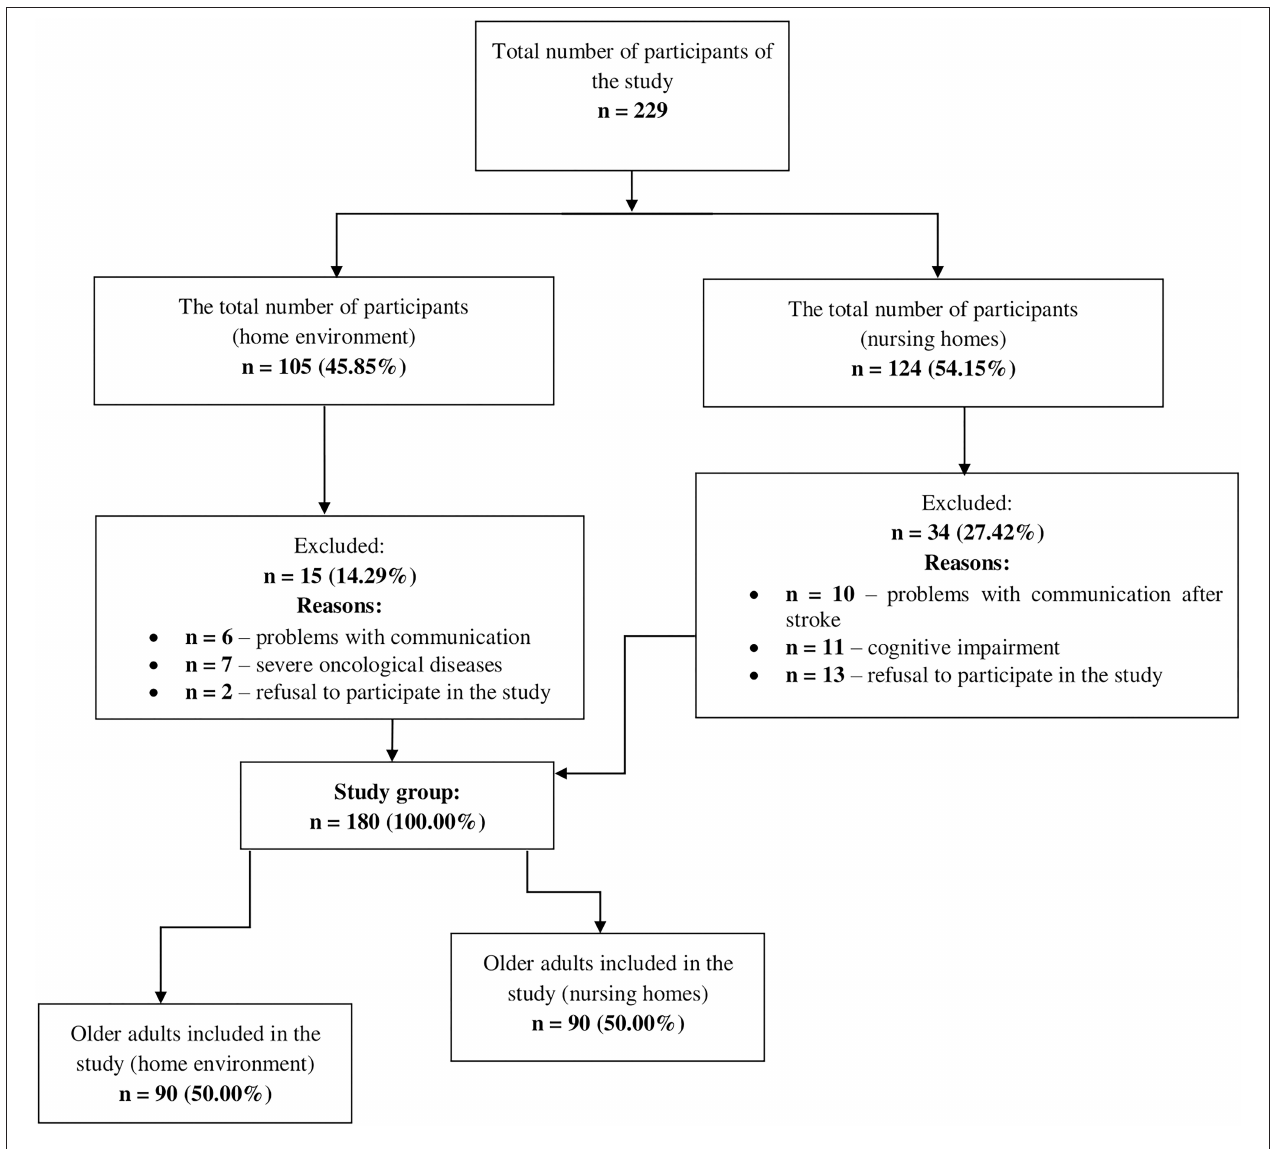
FIGURE 1 | Patients enrolment in the